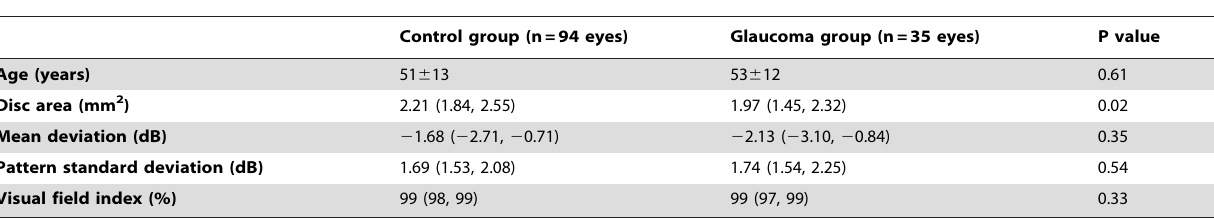
Table 1. Demographic and visual field characteristics of the patients.